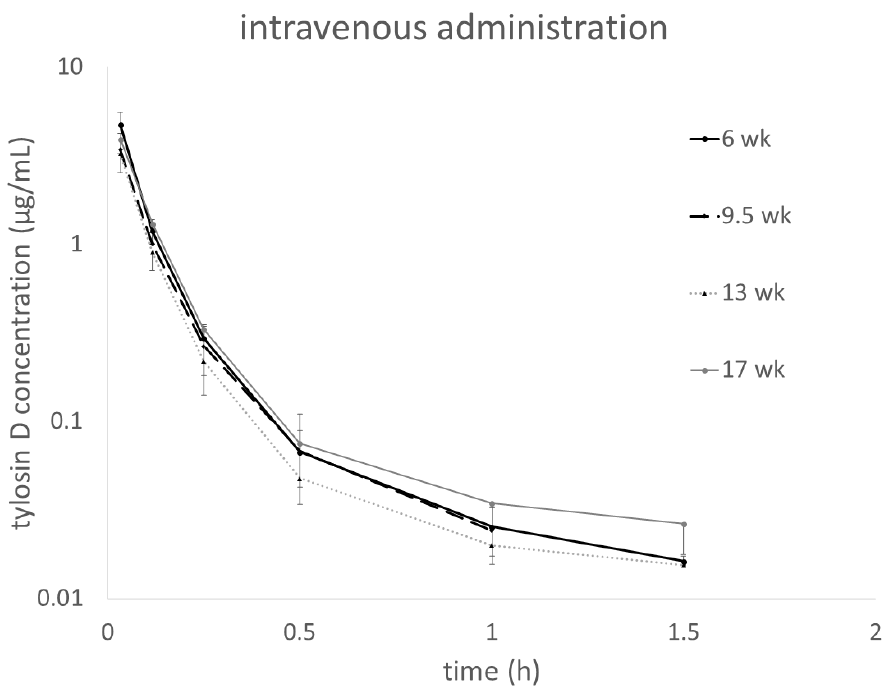
Figure 2. Plasma tylosin D concentrations after single intravenous dose of tylosin tartrate calculated according to the protocol: Dose = 31.6 × BW 0.58 .